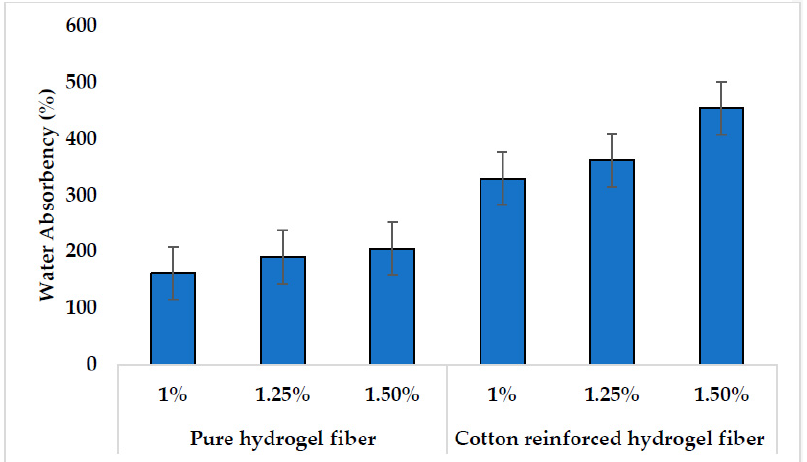
Figure 11. Water absorption property of pure hydrogel fiber and cotton reinforced hydrogel fiber at different concentrations.